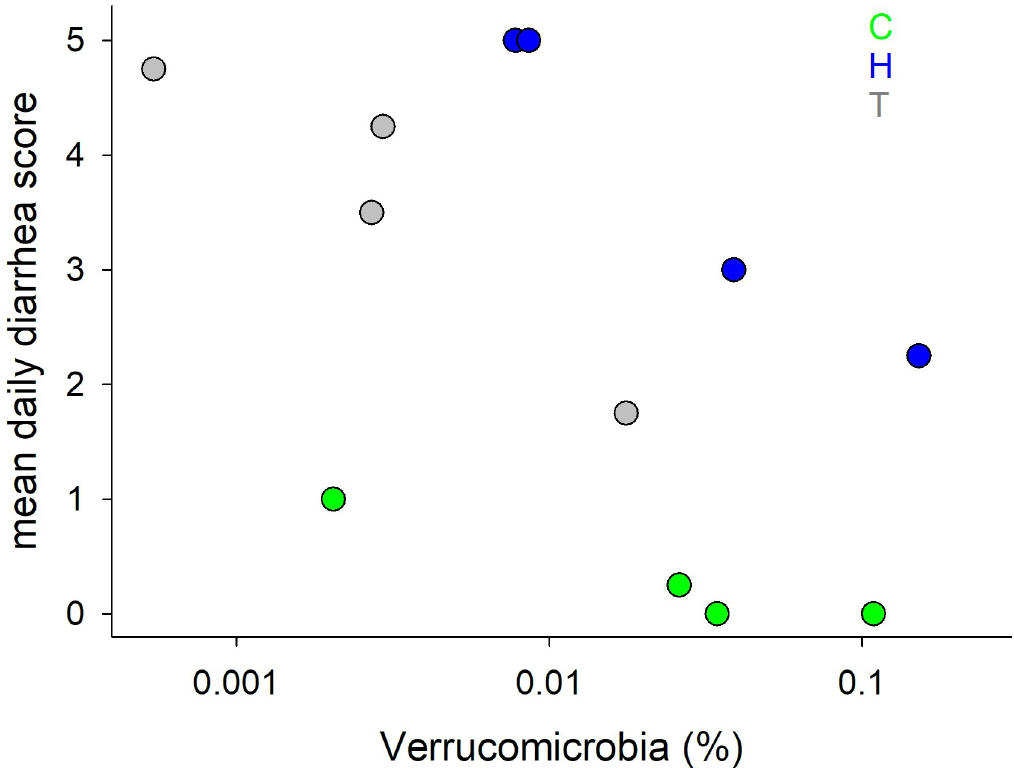
Fig 6. Relative abundance of Verrucomicrobia is negatively correlated with mean daily diarrhea score in transplant recipients. Color indicates FMT recipients as shown in the key.